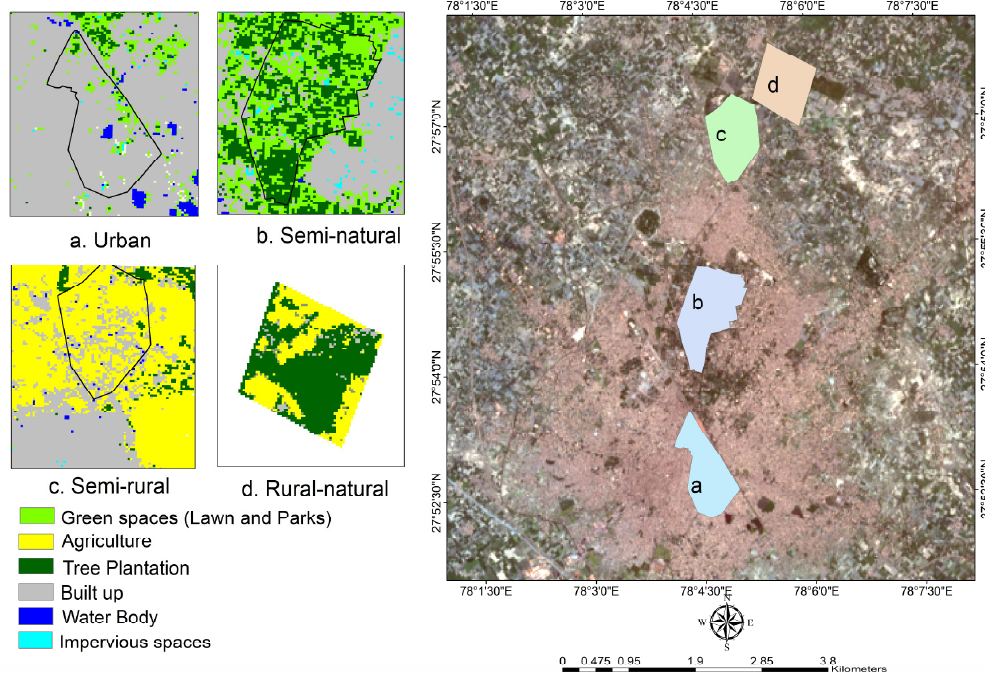
Fig. 2. Study sites in Aligarh, Uttar Pradesh, India a) Urban, b) Semi-urban c) Semi-rural d)